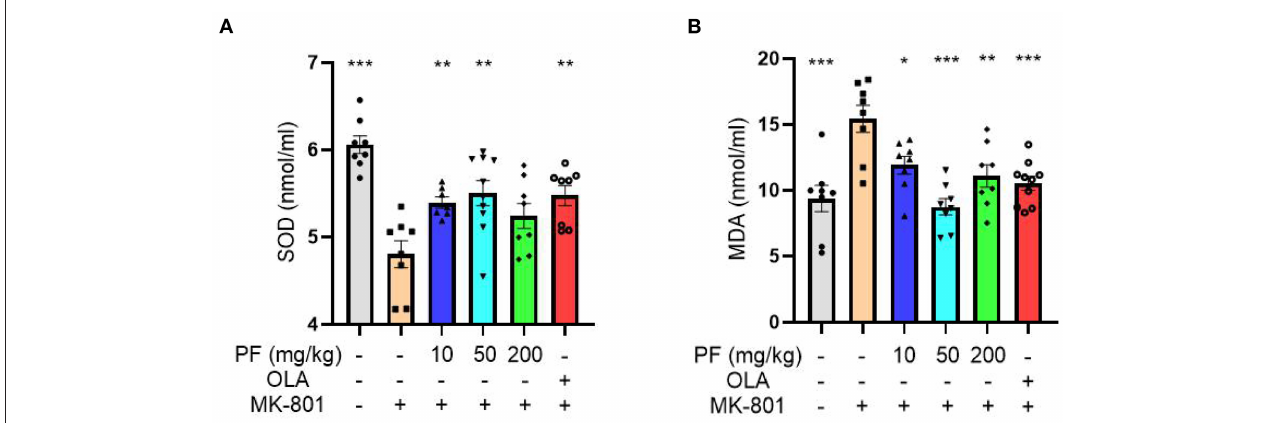
FIGURE 2 | Paeoniflorin (PF) ameliorated MK-801-induced oxidative stress in mice. (A) MK-801-treated mice exhibited reduced superoxide dismutase activity in serum ( P < 0.001), and 10 mg/kg ( P < 0.01) and 50 mg/kg ( P < 0.01), but not 200 mg/kg ( P > 0.05) PF administration significantly increased SOD activity in the model mice. (B) The enhanced serum MDA content found in the model mice was significantly reduced by the treatment of PF at 10 mg/kg ( P < 0.05), 50 mg/kg ( P < 0.001) and 200 mg/kg ( P < 0.01). Three-way ANOVA statistics: F A = 9.849, P < 0.001; F B = 8.751, P < 0.001. Values are the mean ± SEM, n = 7–10/group. * p < 0.05, ** p < 0.01, *** p <